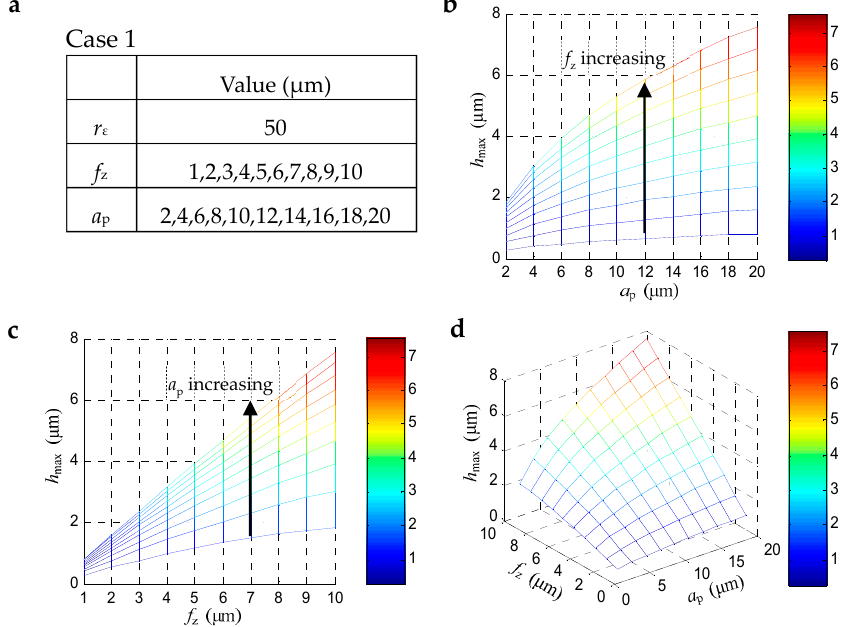
Figure 3. The maximum uncut chip thickness h max changes with f z and a p : ( a ) parameters setting, ( b ) 2D-view from the perspective of a p , ( c ) 2D-view from the perspective of f z , ( d ) 3D-view from both f z and a p .